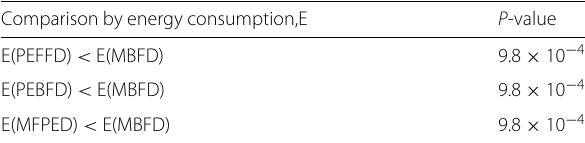
Table 7 Statistical test for the significance of energy saving by the proposed algorithms Comparison by energy consumption,E P -value E(PEFFD) < E(MBFD)